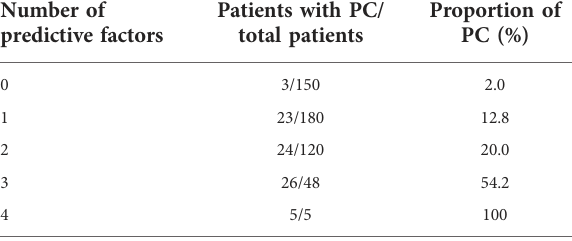
TABLE 2 Proportion of patients with PC in different groups.